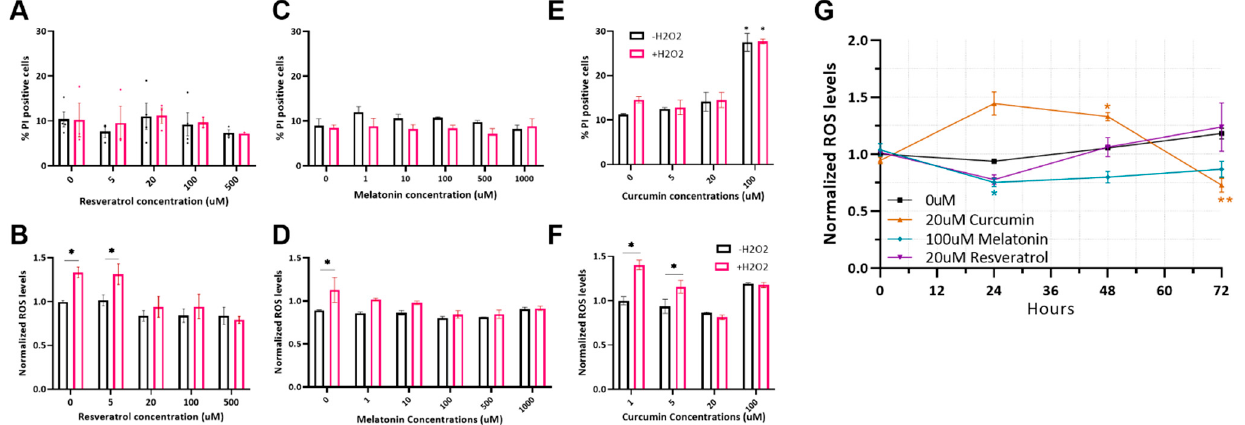
Figure 1. Calibration of antioxidant activity in MSC cells. ( A ) Percentage of dead cells by propidium iodide-staining and analysis by flow cytometry after incubation with resveratrol for 24 h at stated concentrations, with and without 500 µ mol/L H 2 O 2 . ( B ) ROS levels in the cells as seen after staining with CellRox reagent and analysis by flow cytometry after incubation with resveratrol for 24 h at the indicated concentrations with and without 500 µ mol/L H 2 O 2 . ( C ) Percentage of cells death after incubation with melatonin for 24 h were measured as in ( A ). ( D ) ROS levels in cells after incubation with melatonin for 24 h were measured as in ( B ). ( E ) Percentage of cells death after incubation with curcumin for 72 h were measured as in ( A ). ( F ) ROS levels in cells after incubation with curcumin for 72 h were measured as in ( B ). For ( A – F ), n = 3. Two-way ANOVA with Tukey test for multiple comparisons was used, different letters indicate significant differences ( p < 0.05). ( G ) Analysis of ROS levels, after incubation with resveratrol, melatonin, and curcumin for 24, 48, and 72. Two-way ANOVA with Dunnett’s test for multiple comparisons was used for statistical analysis (* = p < 0.05, ** = p < 0.001), n =